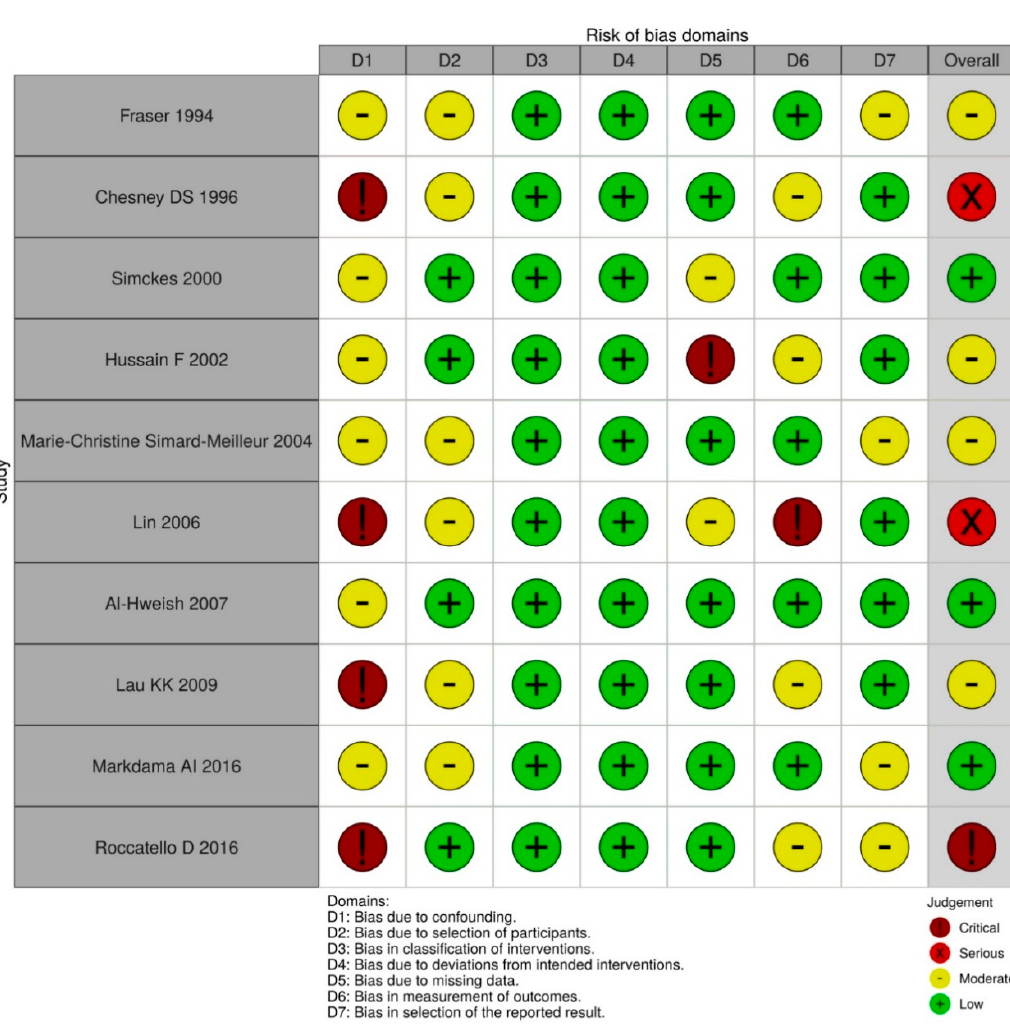
Figure 2. Methodological assessment.